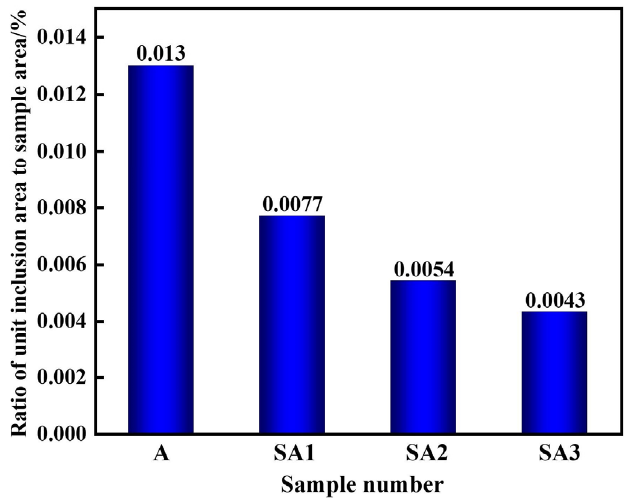
Figure 8. Ratio of unit inclusion area to sample-scanning area in various samples after slag reaction.